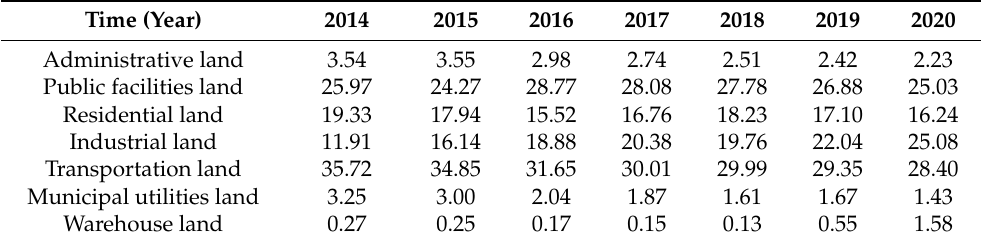
Table 2. Land-use structure types in Laos’ SEZs from 2014 to 2020 (unit: %). Time ( Year )